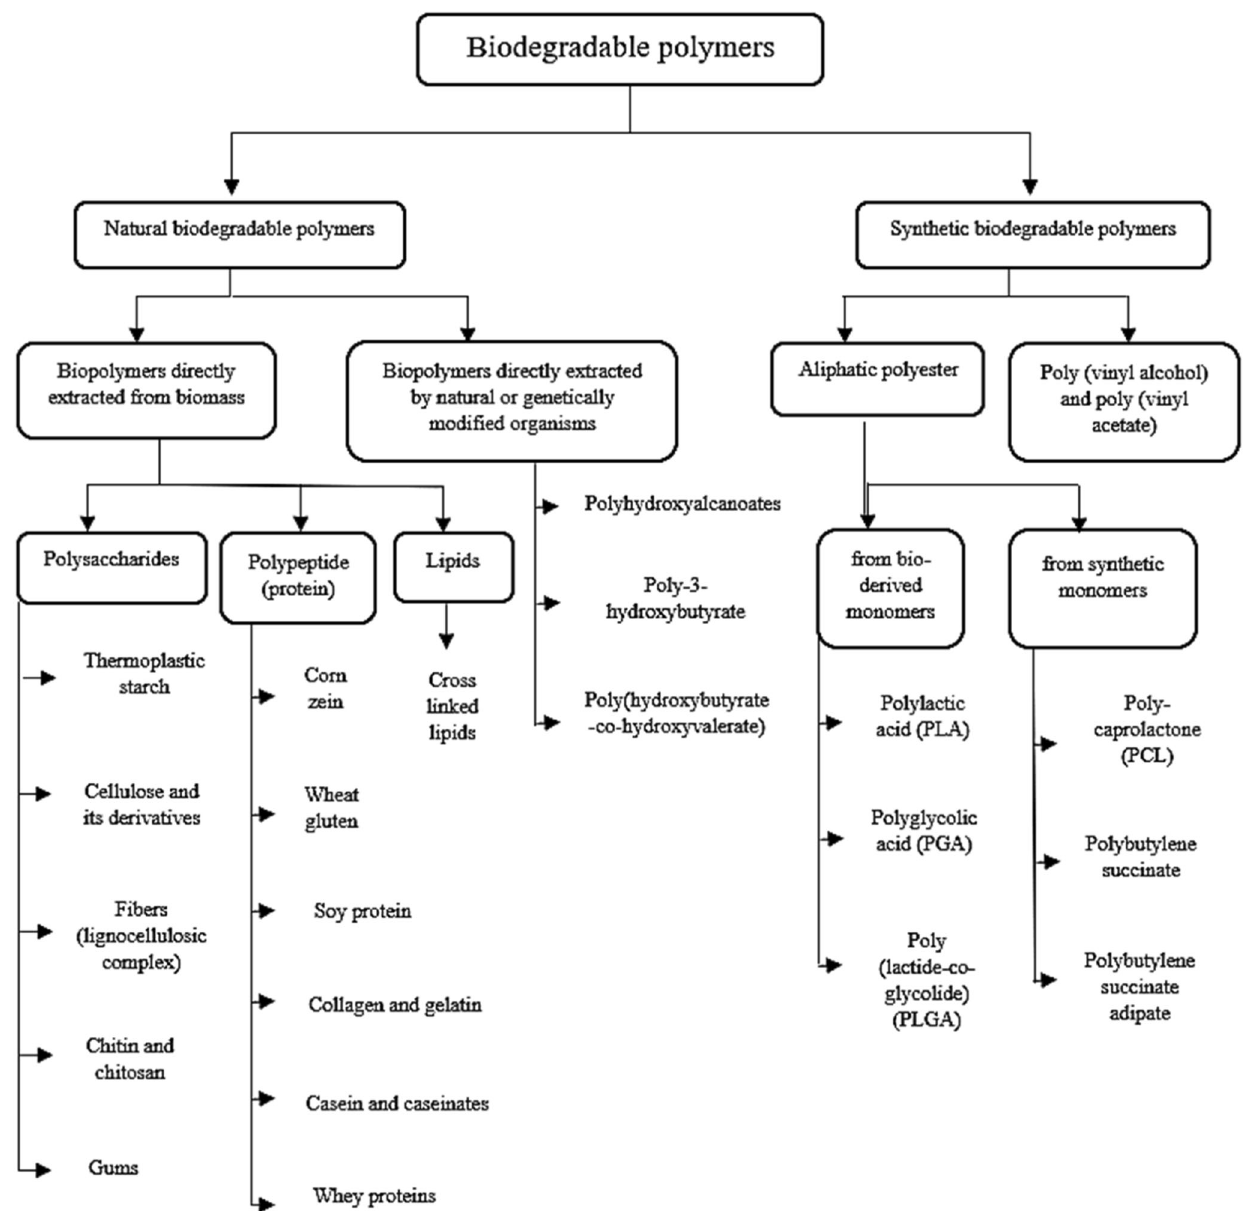
Fig. 3 Classi fi cation of biodegradable polymers. Schematic shows biodegradable polymers classi fi cation based on their origin and method of